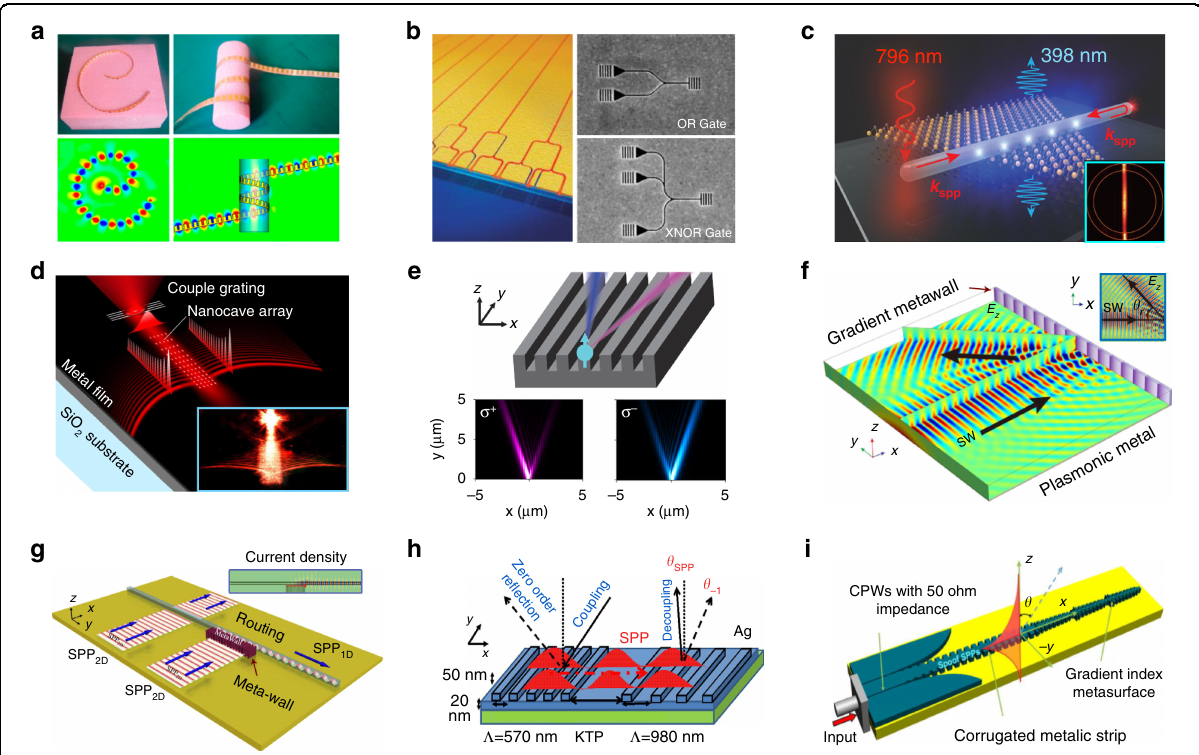
Fig. 9 Manipulations of surface waves via meta-structures. a Spoof SPP transmission lines constructed by subwavelength comb-shaped corrugated metal strips 344 : Fabricated samples ( fi rst row) and simulated electric fi eld distributions (second row). b All-optical nanoscale SPP logic gates: Schematics (left panel) 347 and representative SEM images (right panels). c SPP silver nanowire waveguide integrated with a single layer of MoS 2 for second harmonic generation. Inset: Fourier imaging microscopy collecting signals 348 . d Inhomogeneous nanohole array fabricated on the silver fi lm for SPP Airy beam generation by non-perfectly matched diffraction 354 . e Hyperbolic metasurface for SPP PSHE in visible regime 124 . f Gradient- phase meta-wall for spoof SPP anomalous re fl ection. Inset: simulated abnormal spoof SPP re fl ection results in x - y plane 73 . g Schematic of the transmissive metawall router for the transformation of 2D SPP to 1D SPP in waveguides. Inset: Simulated current density in plasmonic router 71 . h SPP hologram meta-grating for vortex beam generation 362 . i SPP decoupling via phase-gradient metasurface 127 . Panels adapted from: PNAS ( a ) 344 ; ACS ( b 347 , c 348 ); APS ( d 354 , f 73 , h 362 ); Springer Nature ( e ) 124 ; De Gruyter ( g ) 71 ; AIP Publishing ( i ) 127